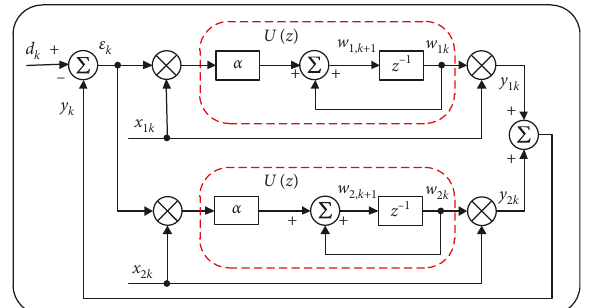
Figure 4: Flow diagram of the LMS adaptive